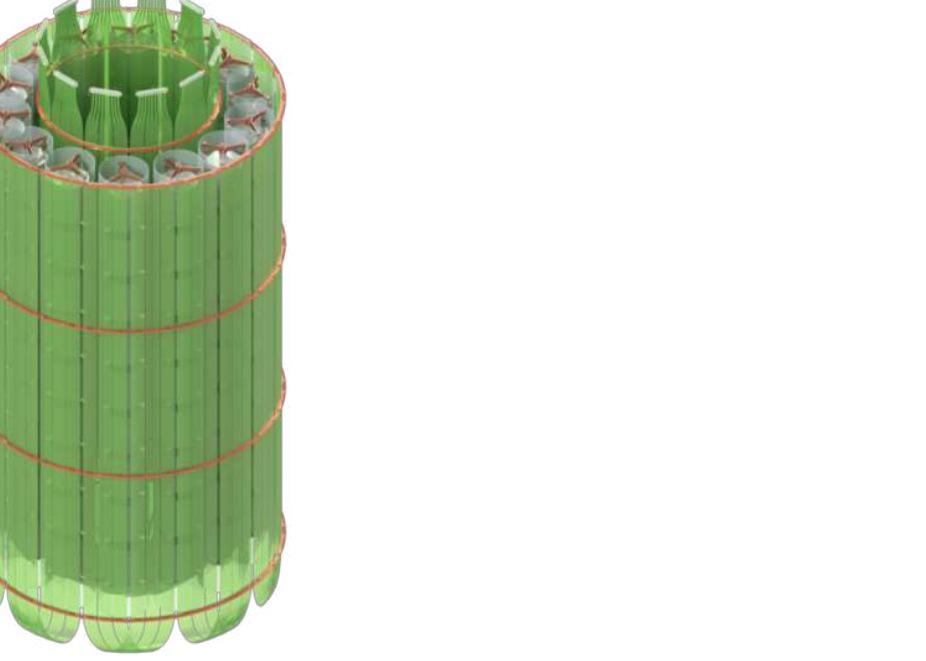
Figure 14. Instrumentation of the LAr volume around the detectors strings in